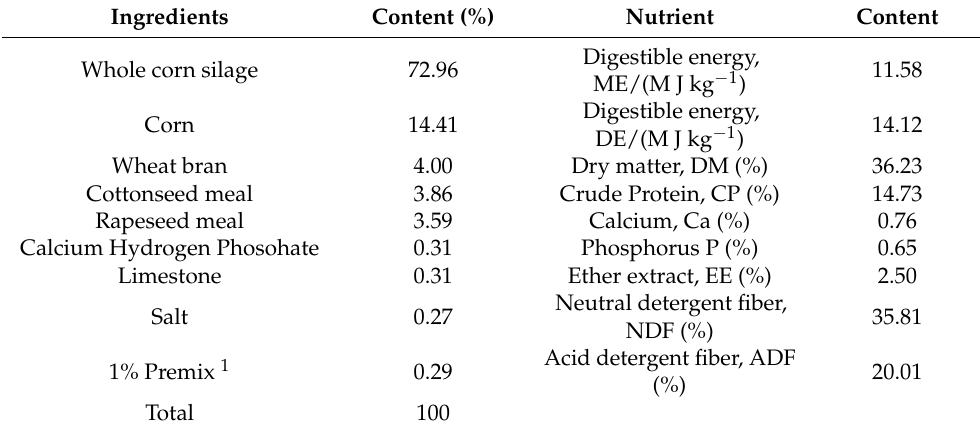
Table 1. Composition and nutrient levels of the fully mixed diet (air drying